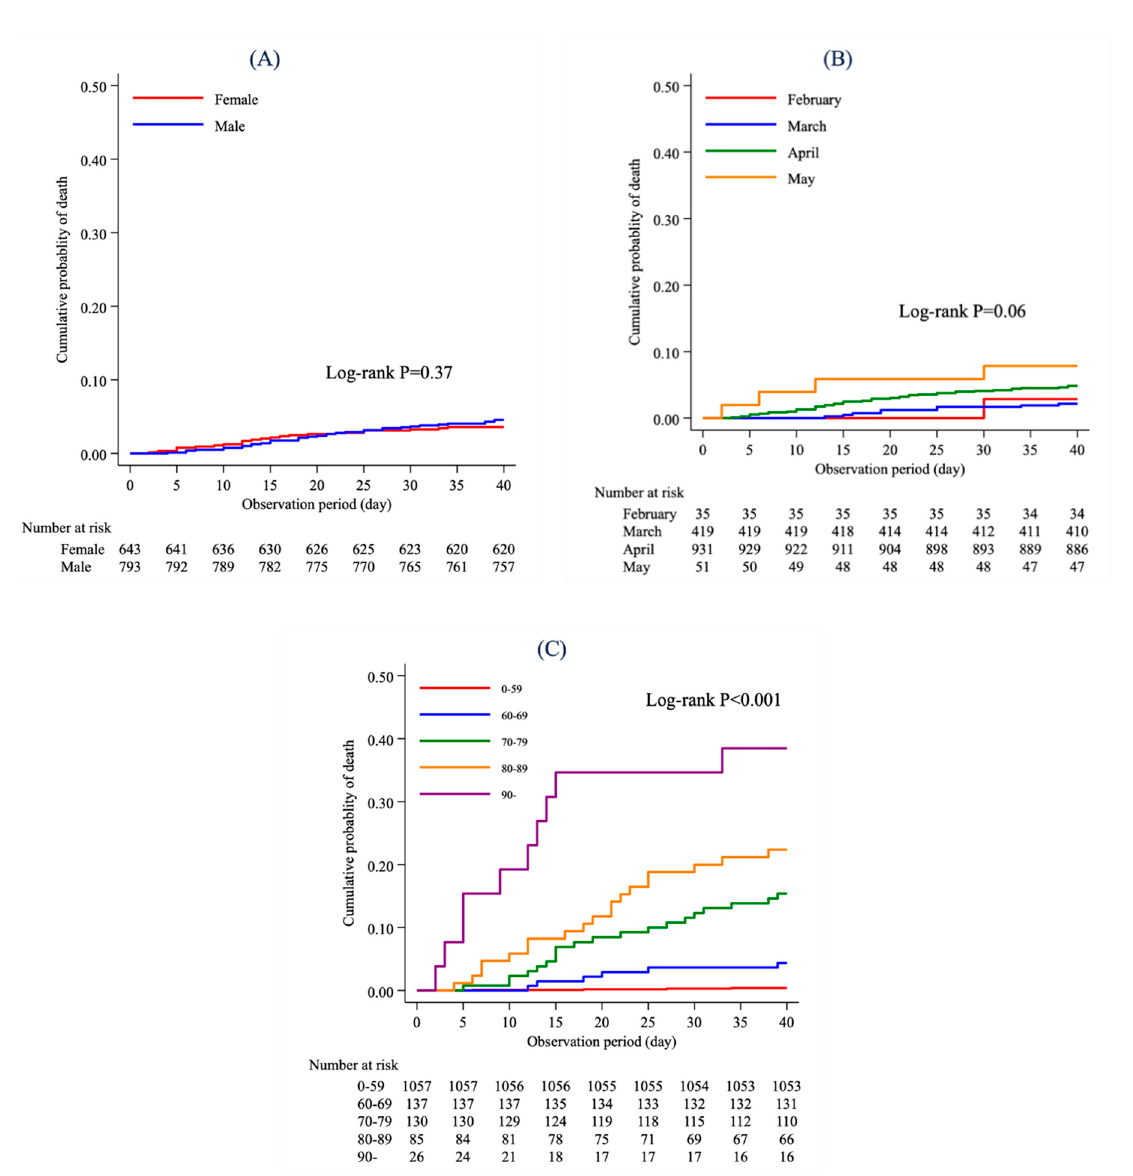
Figure 1. Kaplan-Meier curve according to ( A ) sex, ( B ) onset month, and ( C ) age group at the onset date.